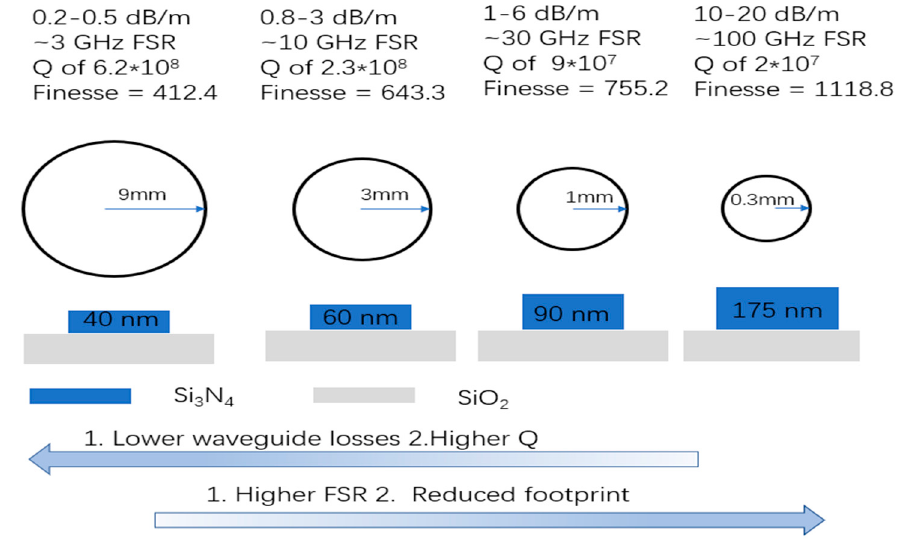
Figure 10. Characteristic of WRRs with di ff erent thickness core and radius.